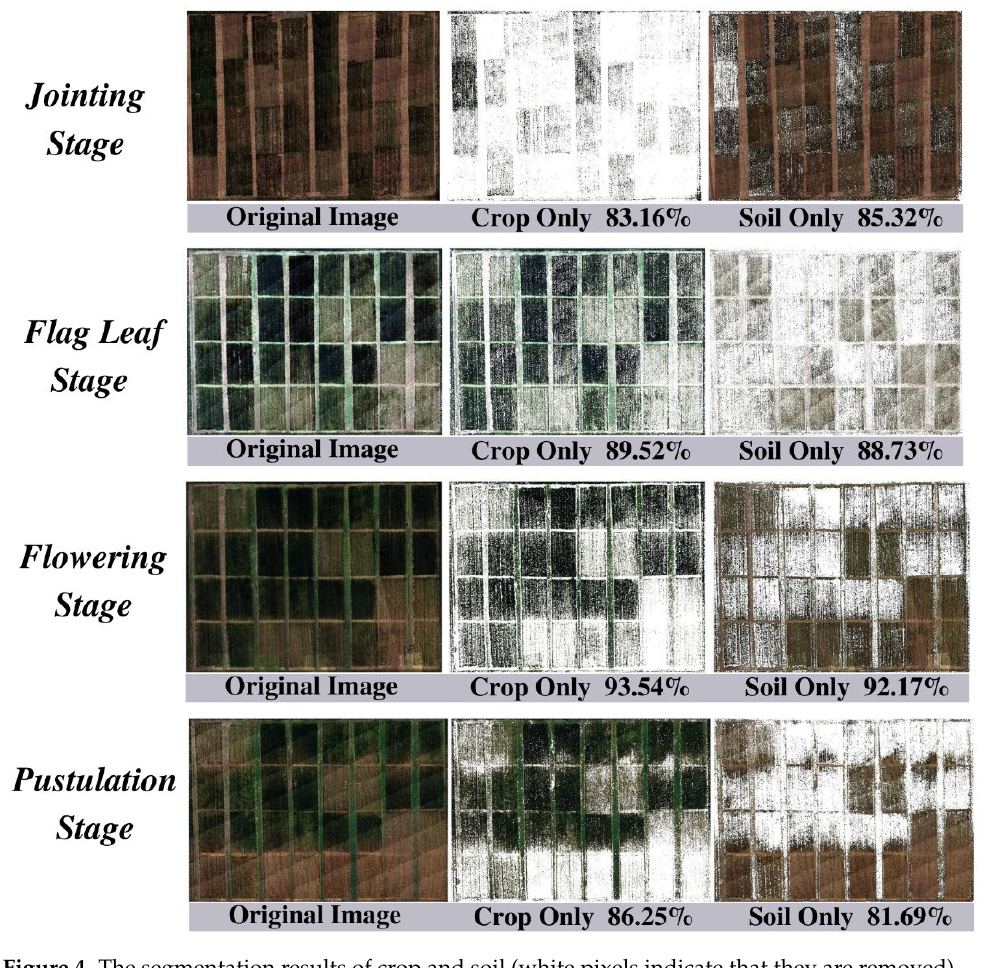
Figure 4. The segmentation results of crop and soil (white pixels indicate that they are removed).